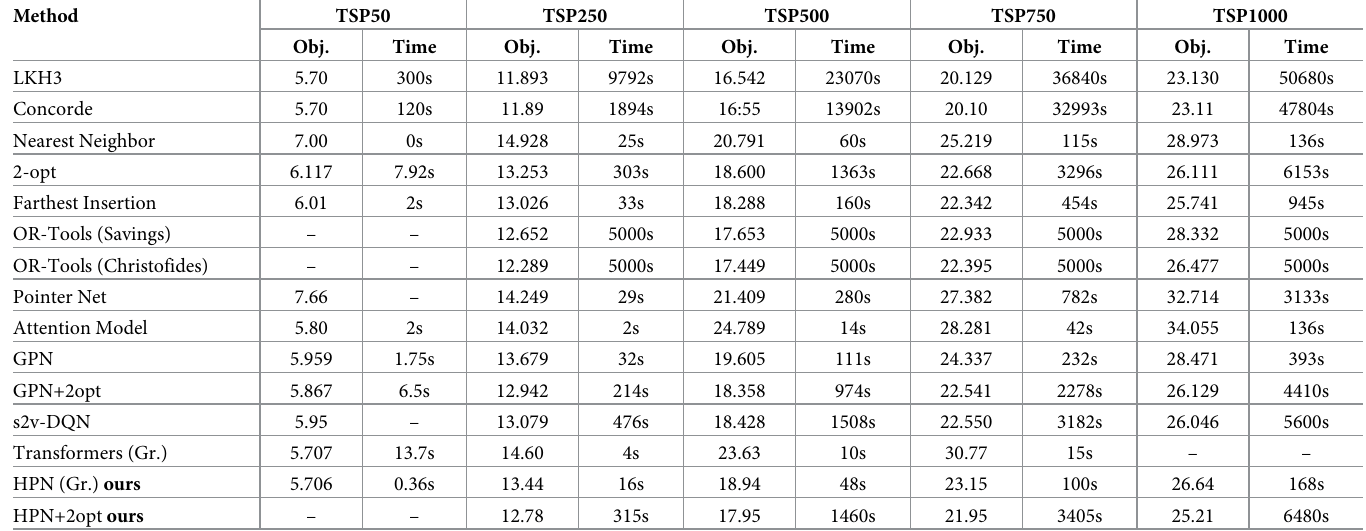
Table 2. TSP’s result using hybrid pointer network model (HPN) vs baselines. Each result is obtained by averaging on 1000 random TSP instances for larger instance and 10k instances for TSP50. Obj is the total tour length and the time reported is for solving 1k instances for larger TSP instances and 10k for TSP50.